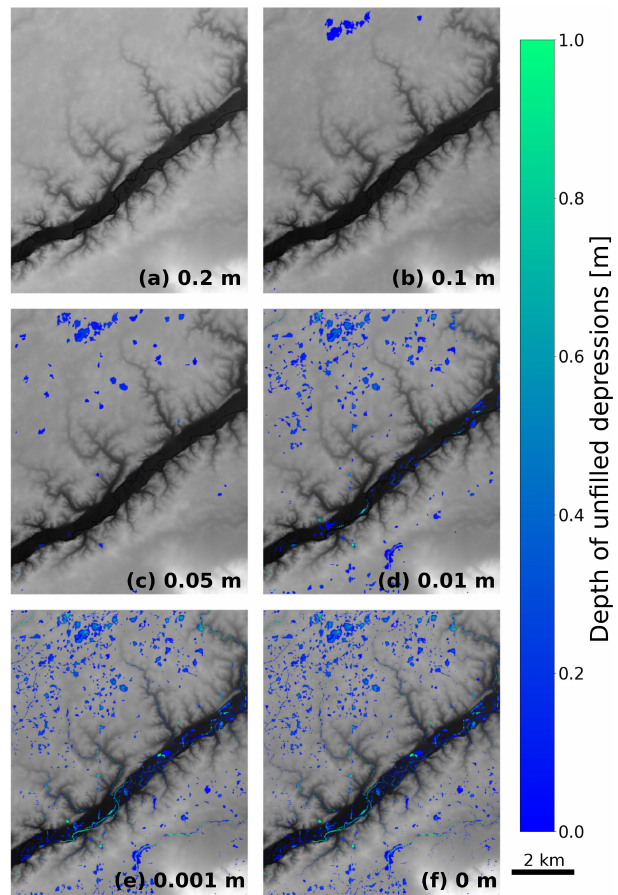
Figure 5. Depressions remaining with different amounts of start- ing runoff at the Sangamon River site. Deeper runoff fills more de- pressions. Unfilled depressions are shown for varying initial runoff depths: (a) 0.2m, (b) 0.1m, (c) 0.05m, (d) 0.01m, (e) 0.001m, (f) 0m (i.e. the input DEM with no changes made). DEM eleva- tions are represented by a dark (low) to light (high) greyscale, while blue and green indicate the depths of depressions still present in the flow-routing surface. In the case of 0.001m runoff, many de- pressions still remain, while with 0.1m of starting runoff all but the largest depressions are filled. Depressions were fully filled with a starting runoff depth of